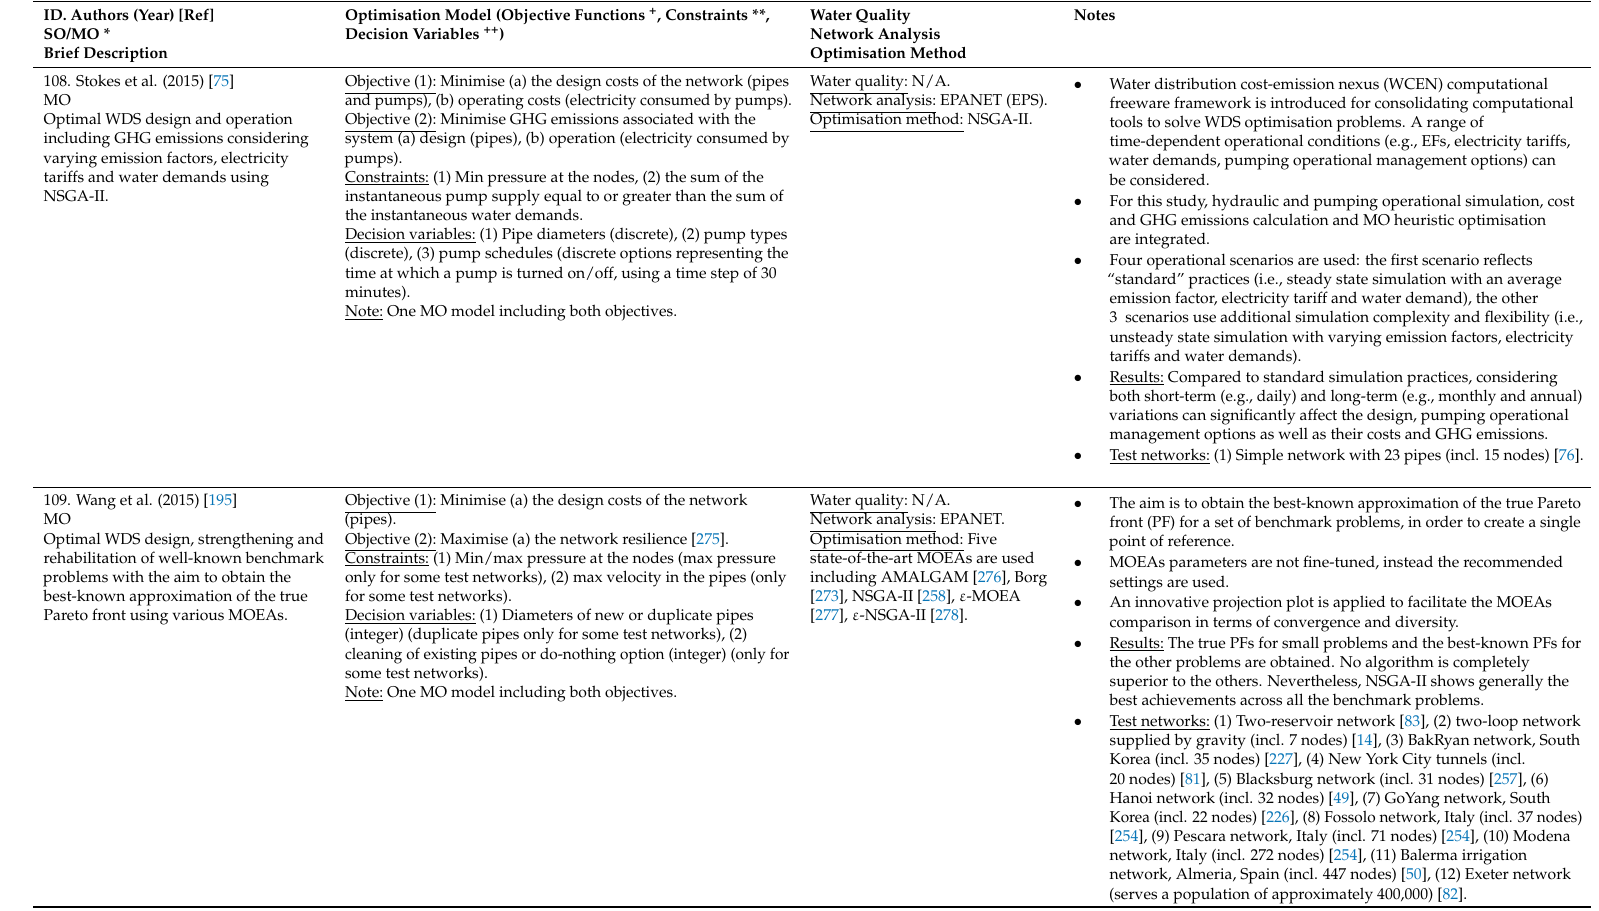
Optimal WDS design, strengthening and rehabilitation of well-known benchmark problems with the aim to obtain the best-known approximation of the true Pareto front using various